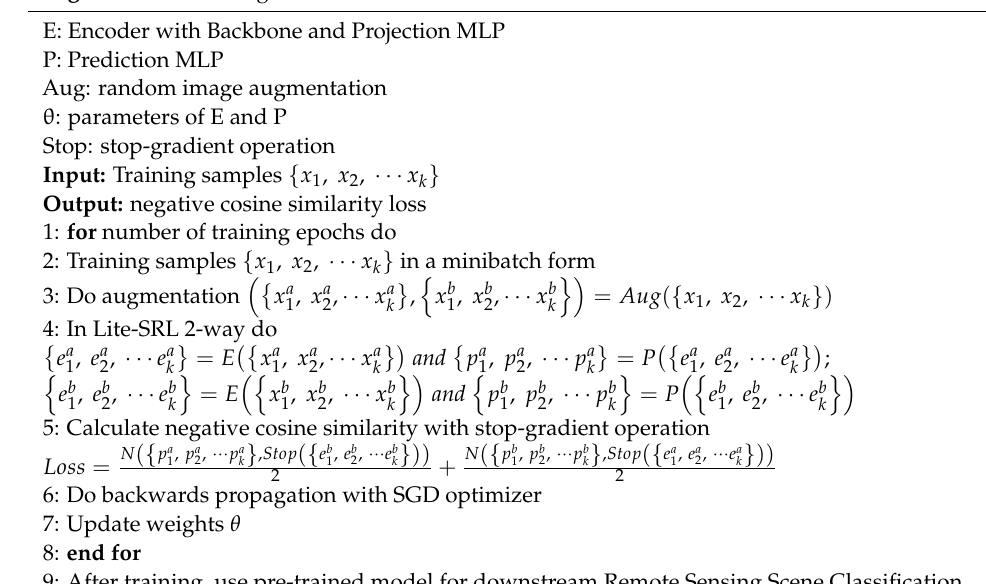
Algorithm 1. Learning Procedure of